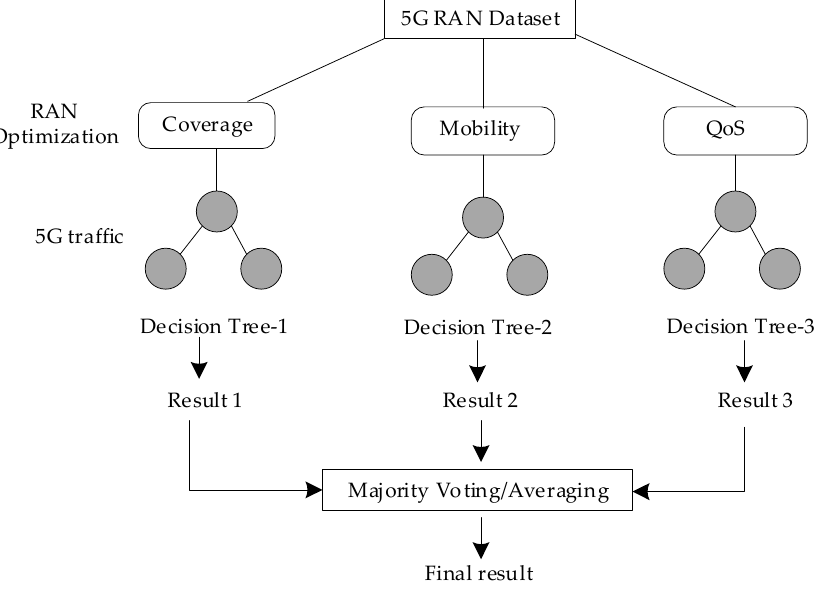
Figure 10. An example of a random forest-based decision for 5G traffic evaluation in association with multiple RAN optimization use cases.